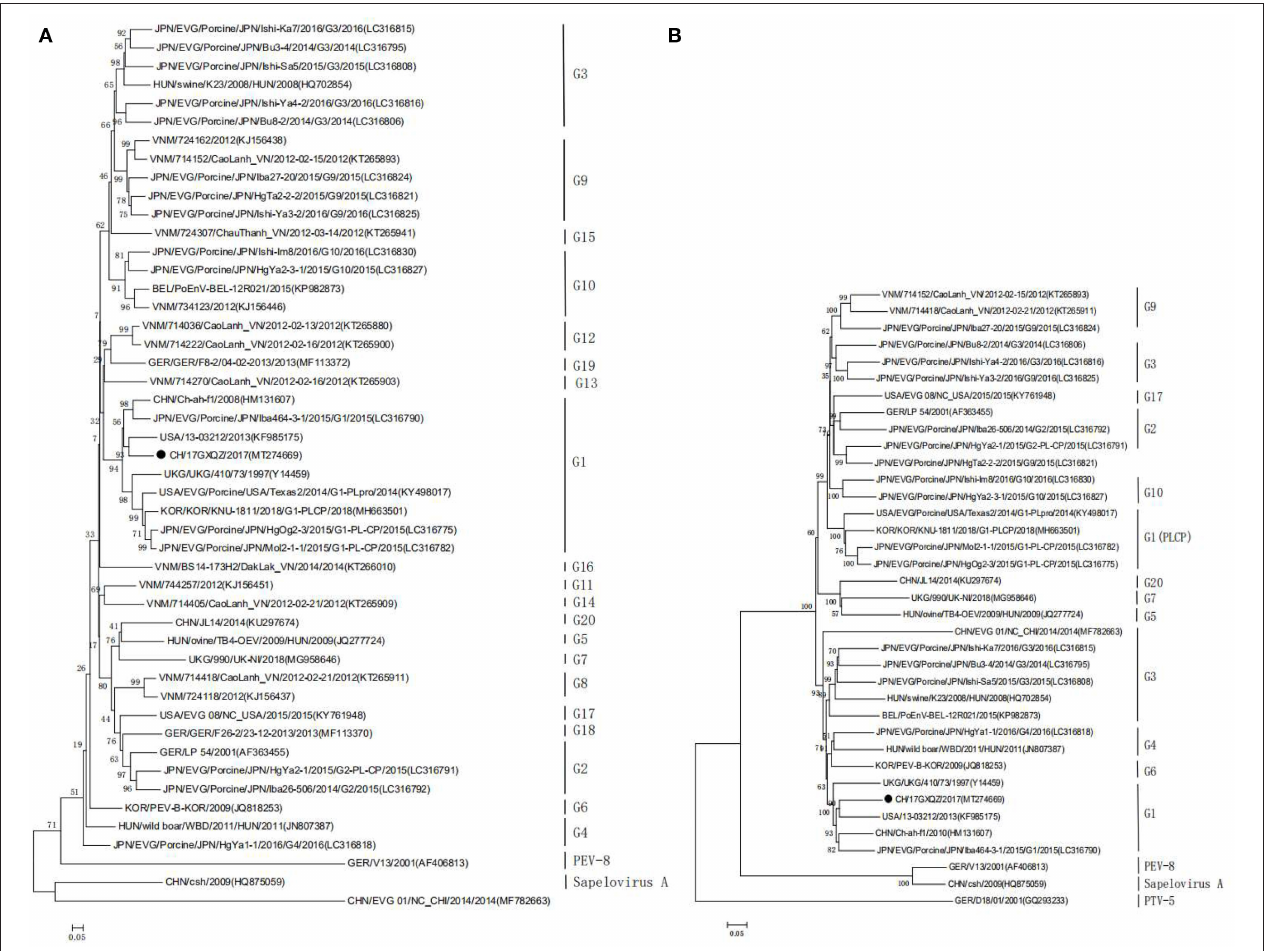
FIGURE 5 | Phylogenetic analyses of the EV-G CH/17GXQZ/2017 strain. Phylogenetic analyses based on the amino acid sequences (A) of VP1 and the complete genome sequences (B) of the EV-G CH/17GXQZ/2017 strain with reference EV-G sequences obtained from the GenBank. The phylogenetic trees were constructed using the maximum likelihood method in MEGA 5.0 software. Bootstrap analysis was carried out on 1,000 replicate datasets and values are indicated adjacent to the branching points. The genetic distances were calculated using the Tamura-Nei model. The EV-G CH/17GXQZ/2017 strain obtained in this study is indicated by solid circles. The scale bars indicate the amino acid or nucleotide substitutions at each